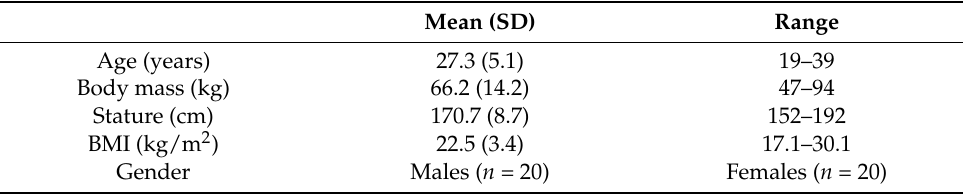
Table 1. Characteristics of the participants ( n =